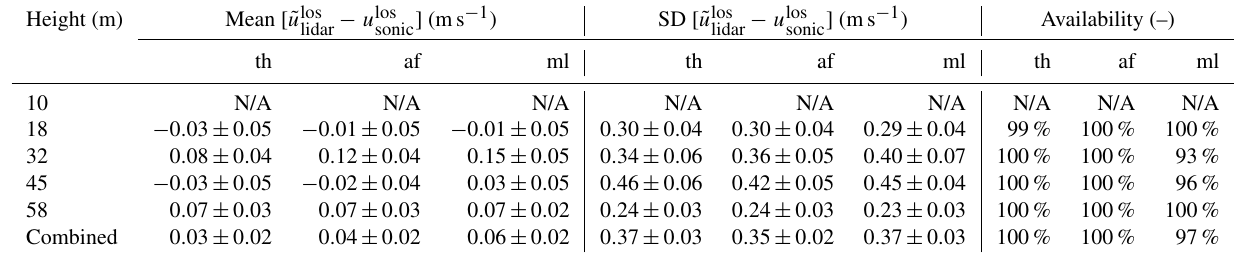
Table 5. Performance of lidar retrieval techniques versus sonic anemometer for waked cases without solid interference. The abbreviations are threshold (th), advanced filter (af), and machine learning (ml). SD refers to standard deviation. Height (m)